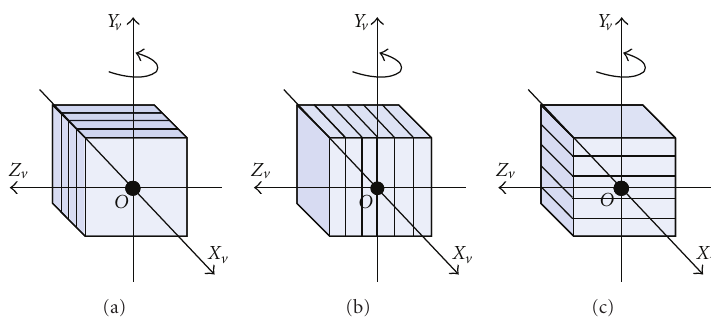
Figure 1: Axis-aligned stack of 2D-textured slices for representing reconstructed volume. (a) along X v axis aligned stack, (b) along Z v axis aligned stack, and (c) along the rotation axis Y v aligned